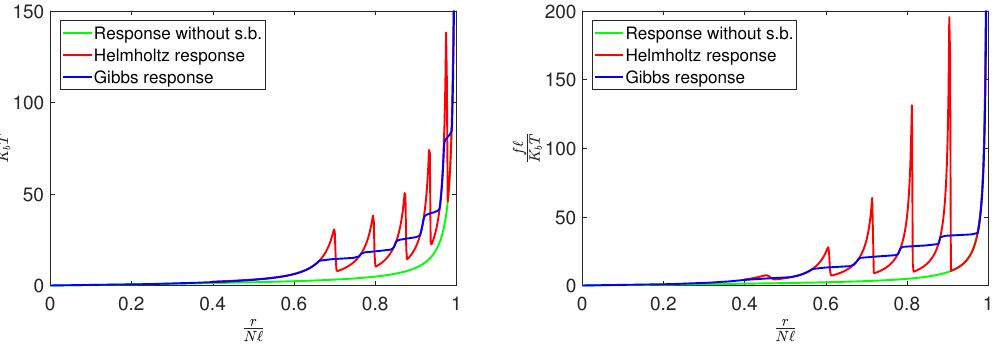
Figure 5. Force–extension response of two chains with s = 5 and different heterogeneous distri- butions of sacrificial bonds under both Gibbs (blue curves) and Helmholtz (red curves) conditions. We also added the response of the same system without sacrificial bonds in order to compare the different behaviors (green curves). On the left panel, we assumed n k = k ∀ k and E k / ( K b T ) = 75 ∀ k , while on the right panel we adopted n k = 5 ∀ k and E k / ( K b T ) = 35 k ∀ k . The plots are represented with adimensional quantities. The other parameters are given by N = 50, h / k = 1, and d / (cid:96) =